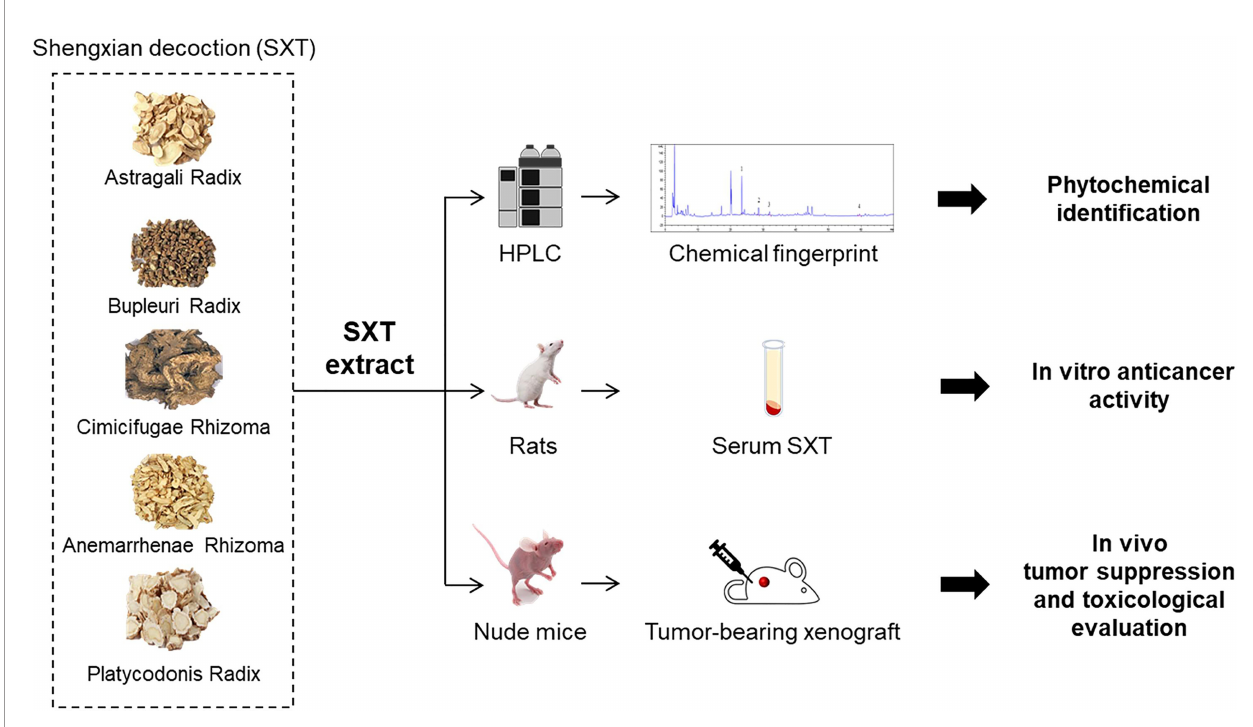
FIGURE 1 | Schematic illustration of the experiment design in this study. Shengxian Decoction (SXT) extracted from fi ve medicinal herbs was subjected to high- performance liquid chromatography (HPLC) analysis for phytochemical identi fi cation, followed by an integrative serum pharmacology-based approach to evaluate cancer killing activity in vitro . The in vivo anti-tumor effect of SXT and preliminary toxicological evaluation was investigated using